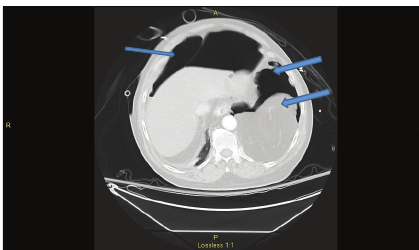
Figure 3: CT scan of abdomen showing pneumothorax on both sides and also herniation of omentum in left thoracic